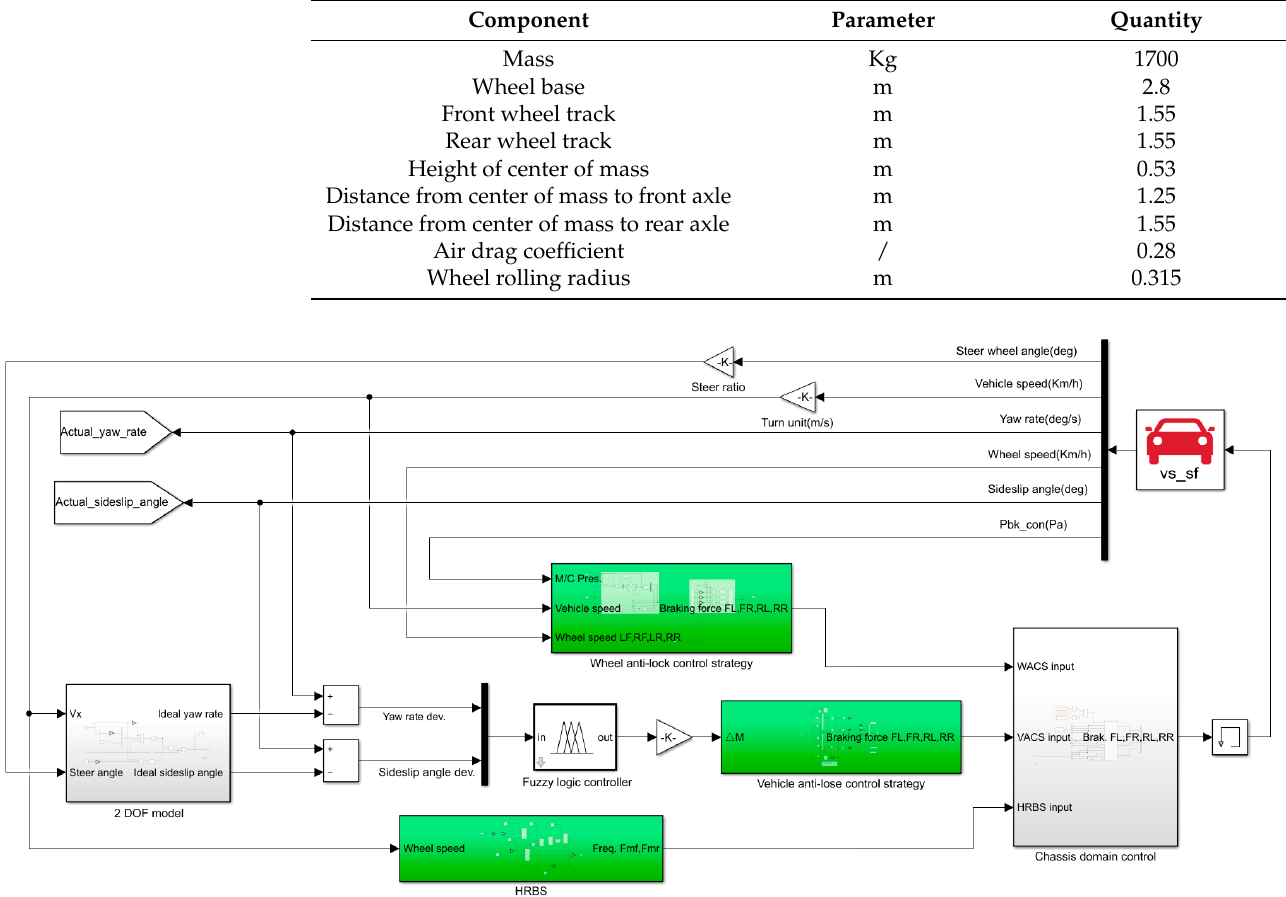
Figure 12. Whole vehicle simulation model based on the chassis